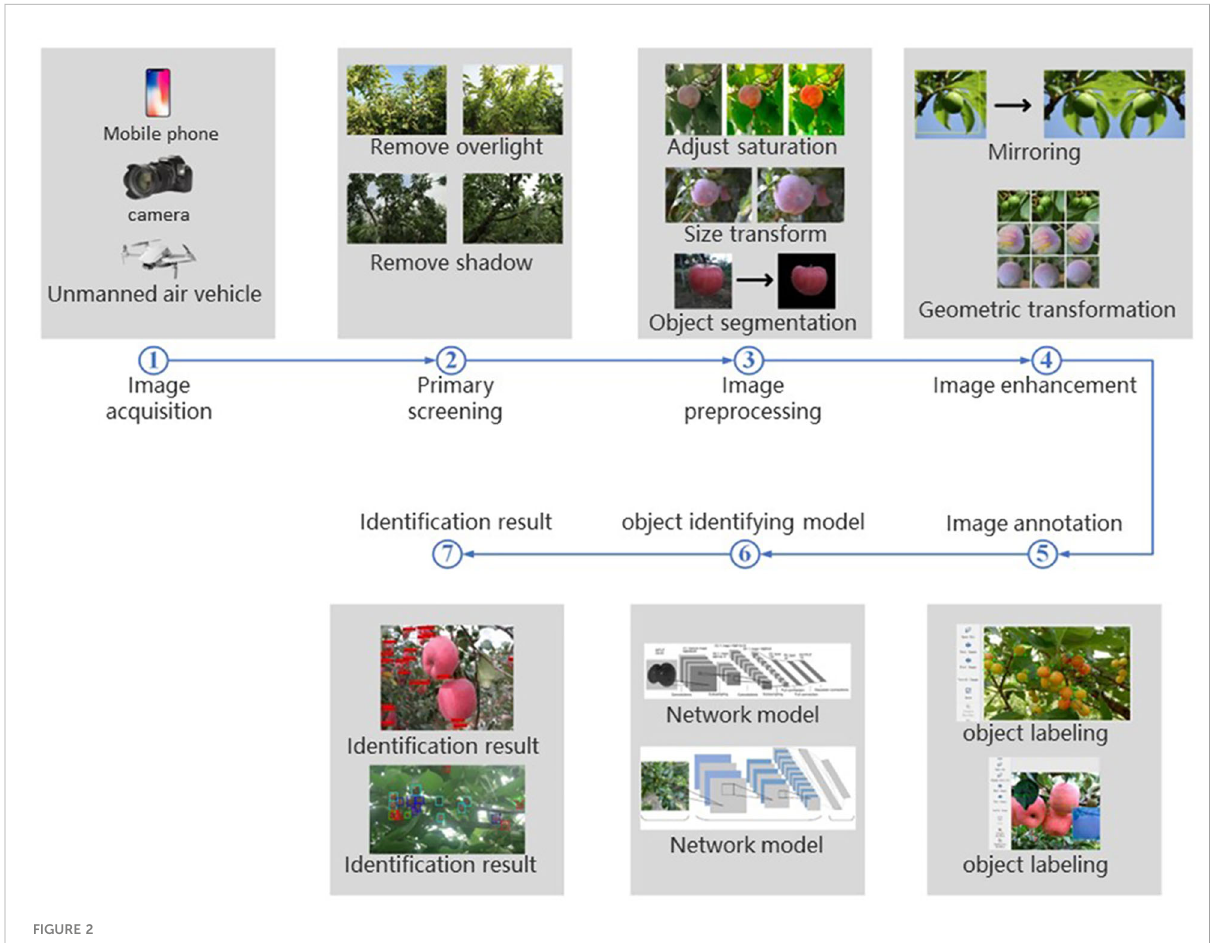
FIGURE 2 Image processing steps in target recognition.